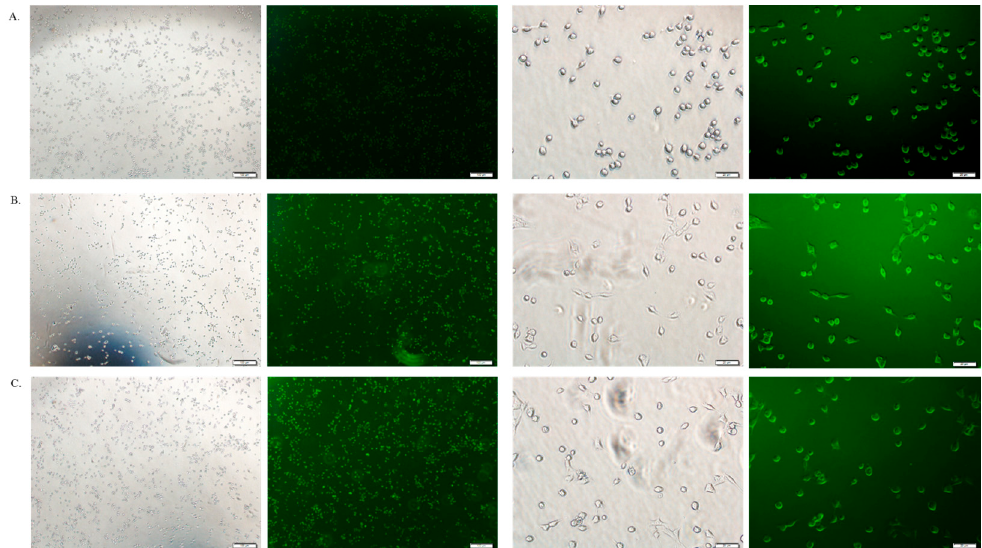
Figure 11. Fluorescence image analysis of MCF-7 cells incubated with DOX 1 µM ( A ) , DOX-loaded CA NPs (1 µM); ( B ) and DOX-loaded CMCA NPs (1 µM); ( C ) at 37 °C for 4 h with 4× and 20× magnifications at a scale bar of 100 µm and 20 µm.